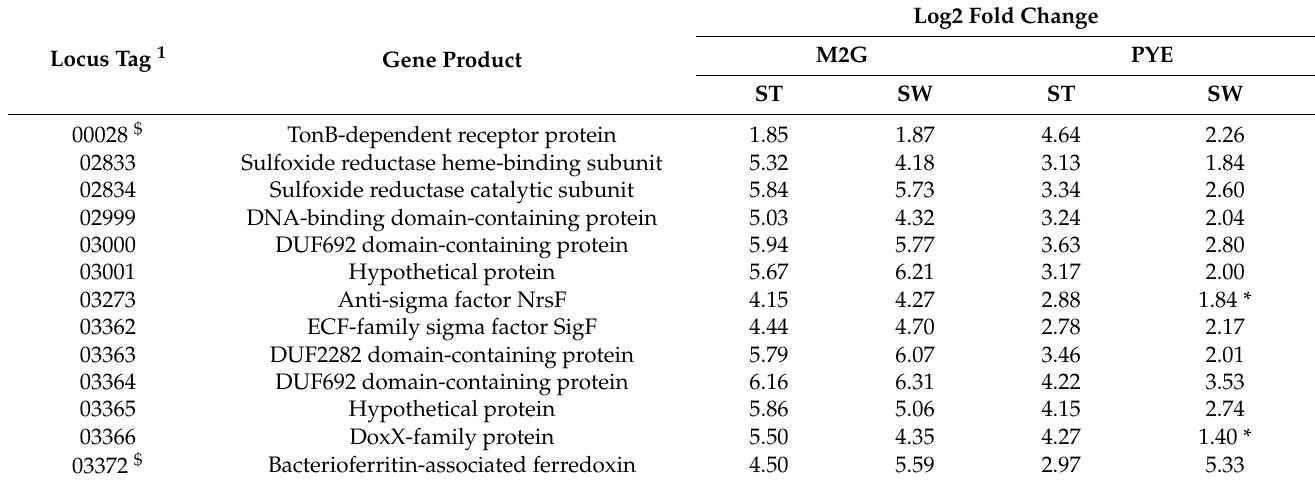
Table 2. List of genes upregulated by Cu stress in all tested conditions and cell types.